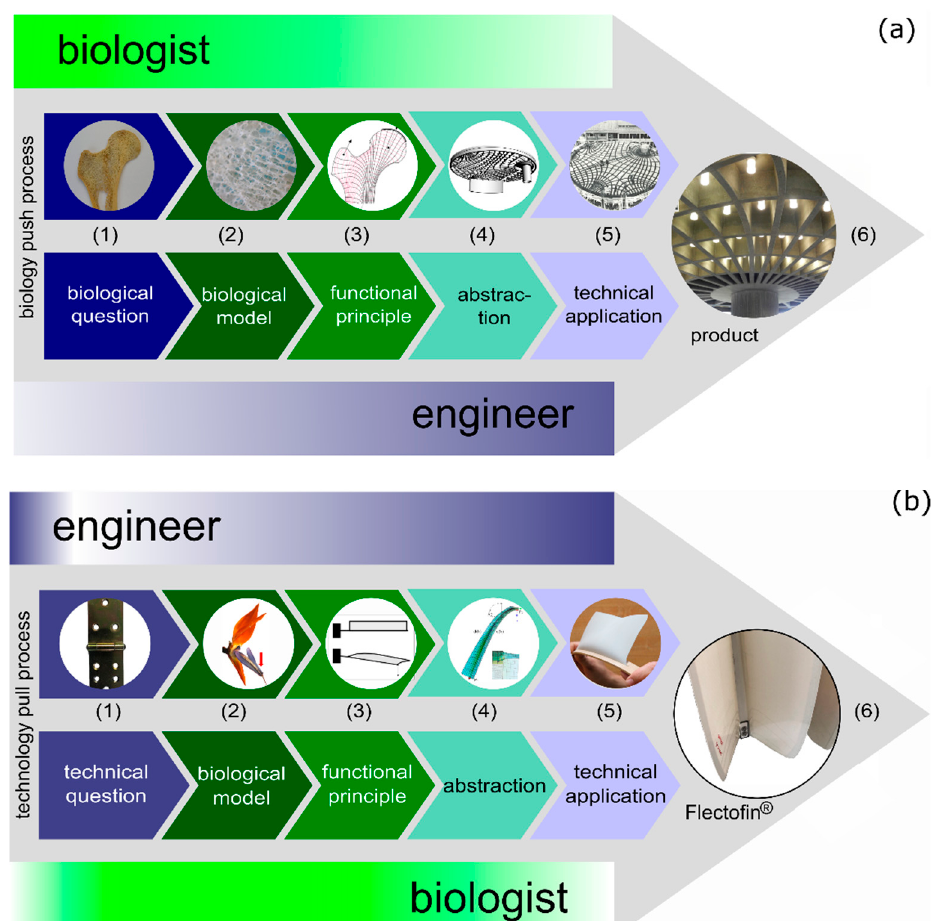
Figure 1. Biomimetic approaches. ( a ) Biology push process (=biomimetic bottom-up approach) of the bone-inspired concrete ceiling of the Old Zoology Lecture Hall at the University of Freiburg, Germany. (1) What makes bone a lightweight construction?; (2) trabeculae of the bone; (3) bone trabeculae align with main forces; (4) model of the ceiling; (5) ceiling in construction (© Bruno Krupp, Freiburg and University Building Authority (Universitätsbauamt) Freiburg).; (6) ceiling detail. ( b ) Technology pull process (=biomimetic top-down approach) of the façade shading system Fectofin ® . (1) How to create a hinge-less motile shading system?; (2) perch of the bird-of- paradise flower; (3) torsional buckling; (4) finite element model (photo courtesy: Simon Schleicher); (5) simple physical model; (6) façade shading system Flectofin ® .